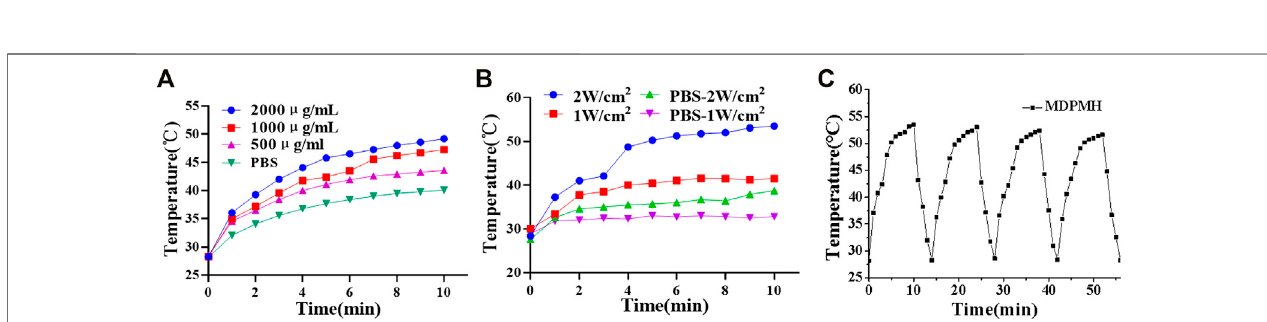
FIGURE 5 | Photothermal curves of the MDPMH at the various conditions with an 808-nm laser, PBS as the control group. (A) The photothermal effect of concentrations (500, 1,000 and 2,000 μ g/ml) at the power energy of 1 W/cm 2 . (B) The effect of laser power (1 W/cm 2 , 2 W/cm 2 ). (C) The temperature variations of MDPMH at 2,000 μ g/ml under 808-nm laser irradiation for 4